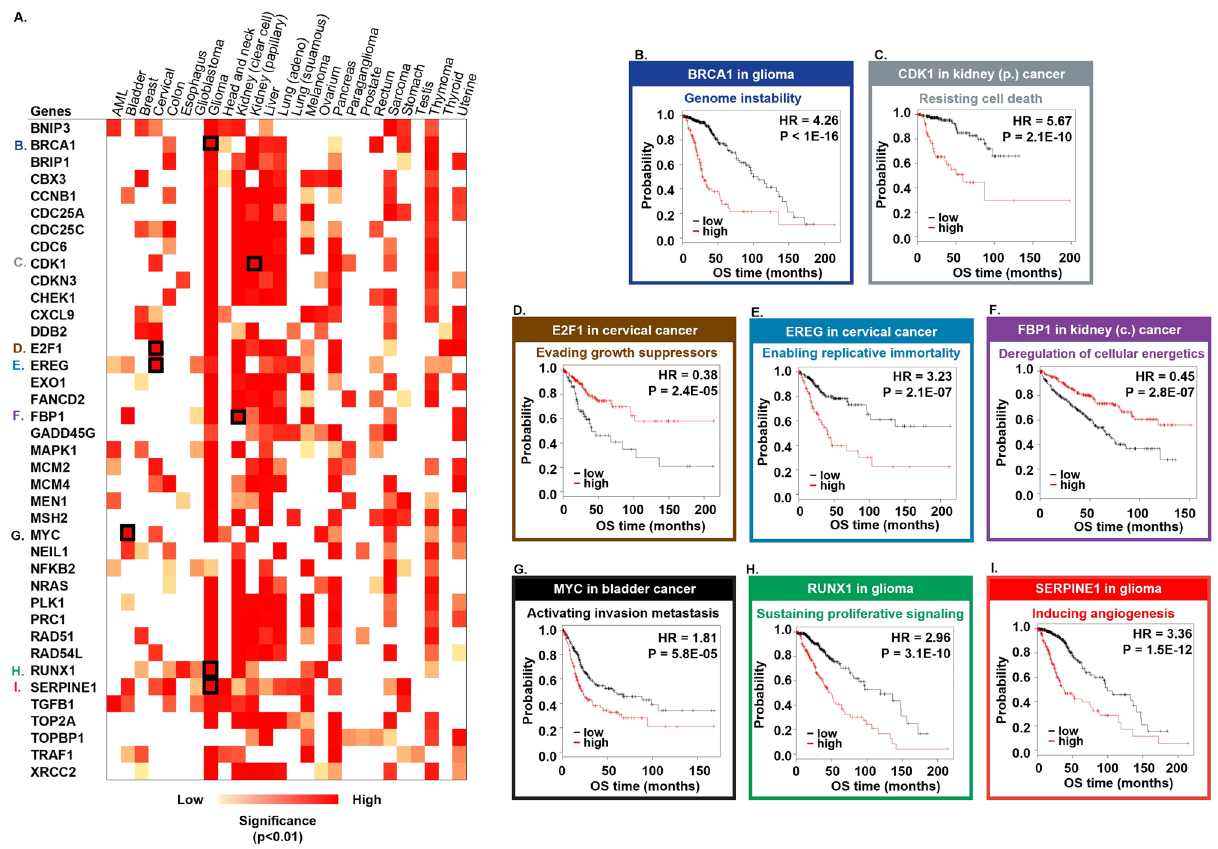
Figure 4. Best performing genes in at least 10 distinct tumor